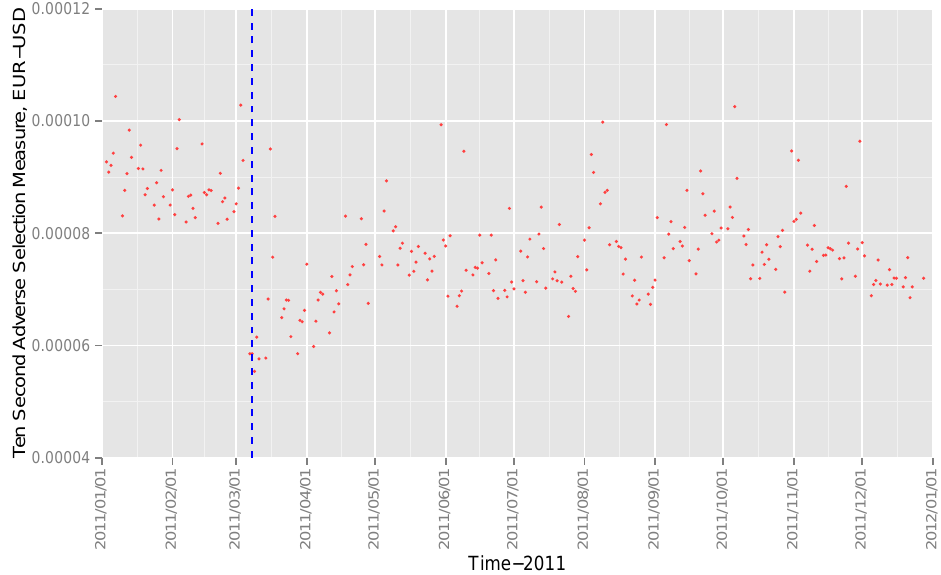
Figure 14. EUR/USD Adverse Selection Proxy, Ten-Second